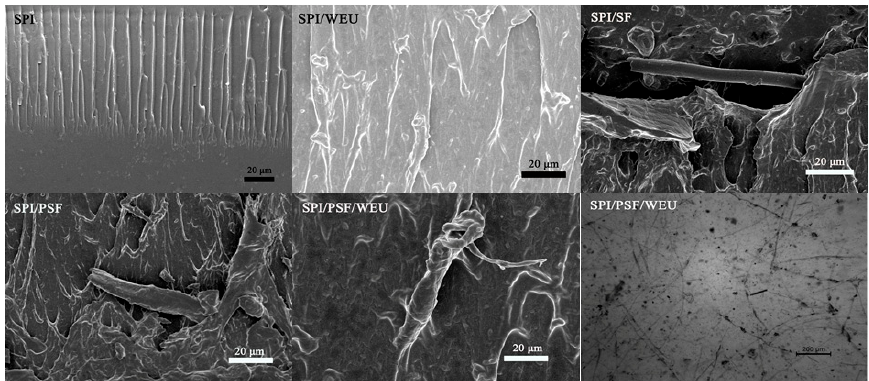
Figure 5. SEM images of neat SPI, SPI/WEU, SPI/SF, SPI/PSF, and SPI/PSF/WEU films’ cross-sectional morphologies and the surface image of the SPI/PSF/WEU film.